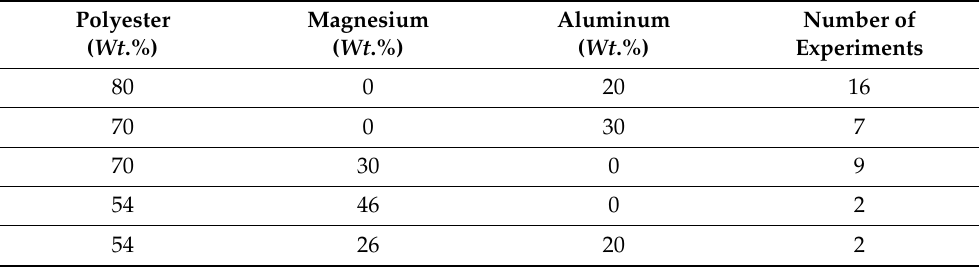
Table 2. Weight percent of polyester, magnesium, and aluminum at the different fuel compositions